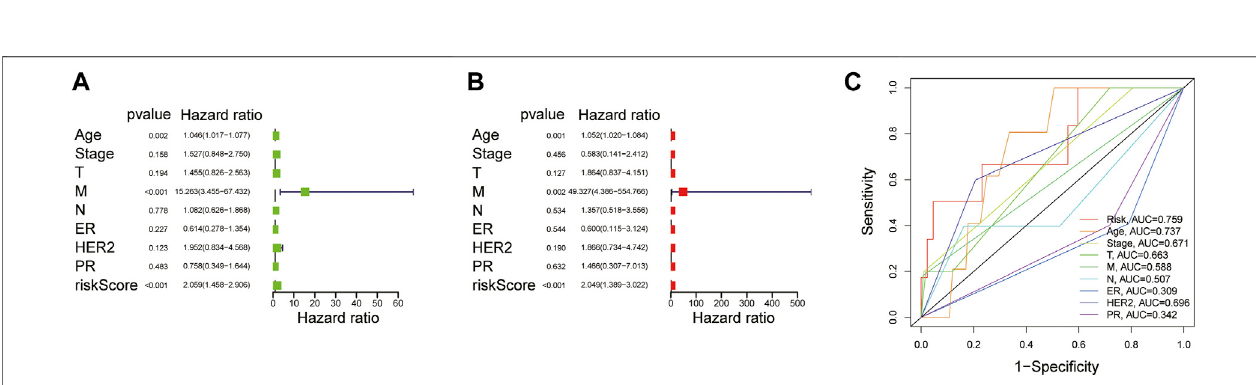
FIGURE 4 | Explore the prognostic value of risk score and clinical features (A) Univariate Cox regression analysis of breast cancer patients (B) Multivariate Cox regressionanalysisofbreast cancerpatients(Waldtest, p < 0.05) (C) TheAUCforriskmodel scoresand clinicalfeatures accordingtotheROCcurves.Clinical features: Age, ER, PR, HER-2, TNM stage, T, N, and